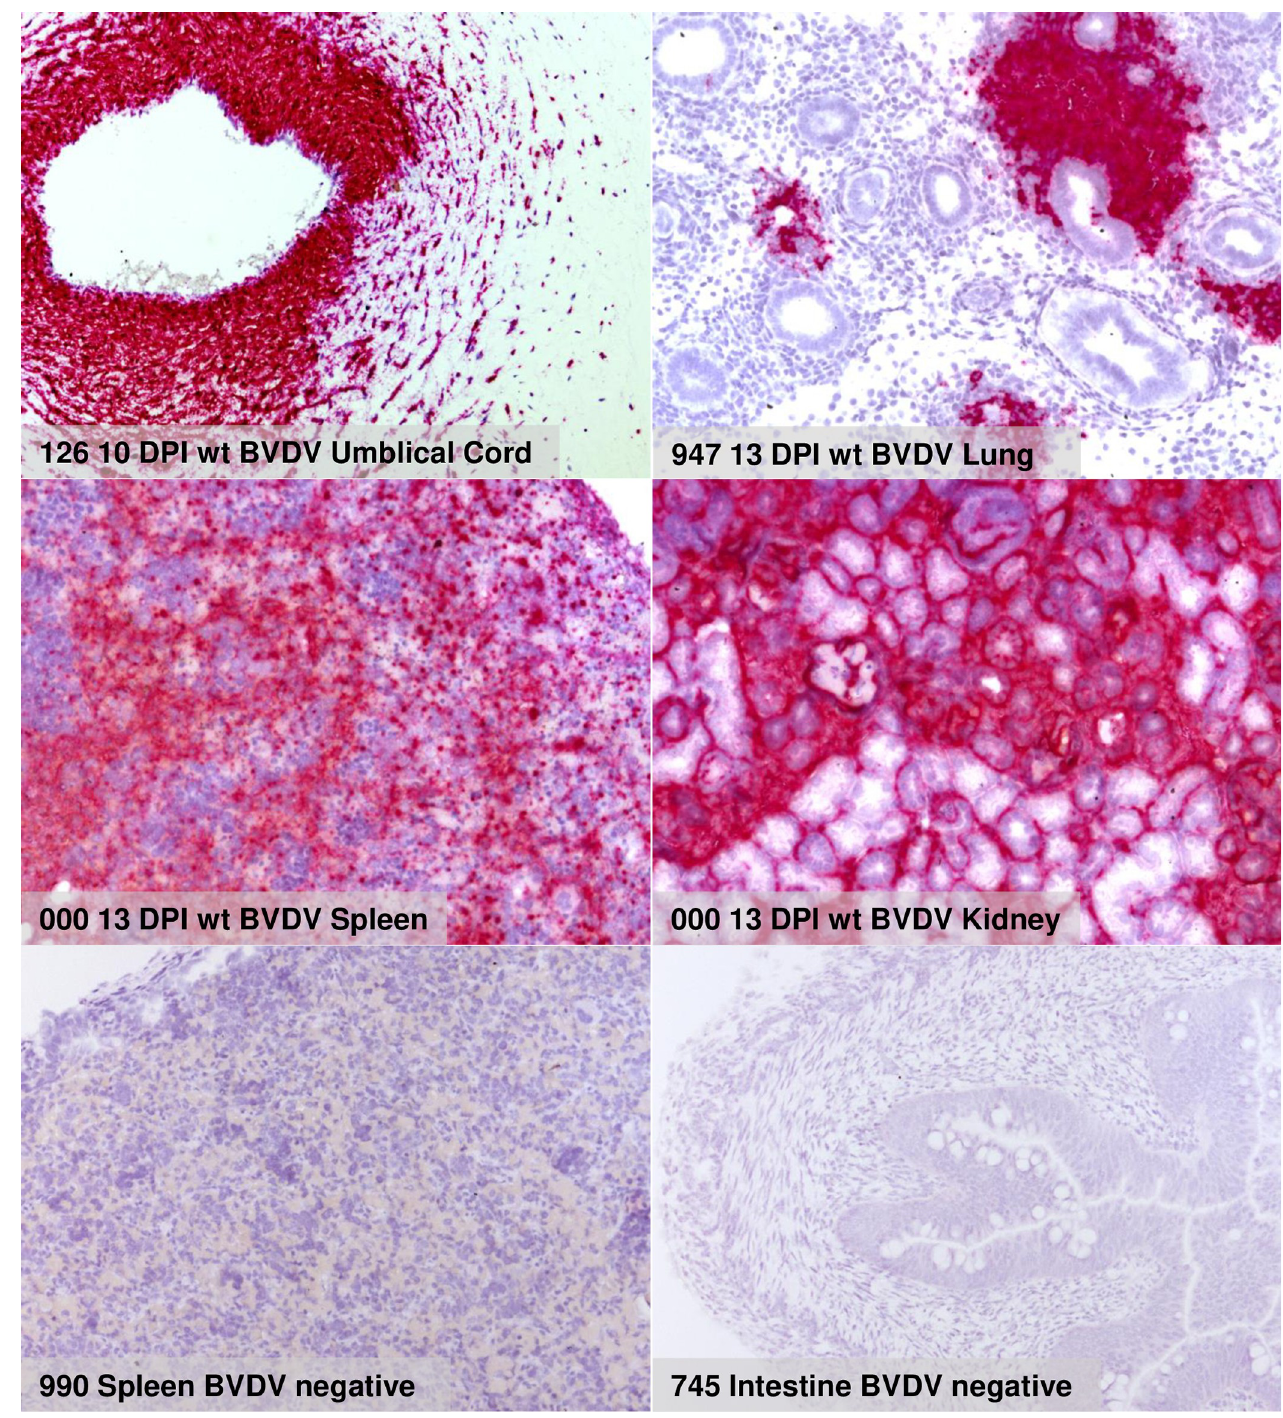
Fig 4. Detection of viral RNA in fetal tissues via RNAscope. The pictures represent the results of RNAscope in situ hybridization of the indicated tissues. The labelling lists from left to right the animal number, the day of slaughter, the virus used for infection and the tissue from which the sample was taken. Red color represents positive staining for BVDV genomic